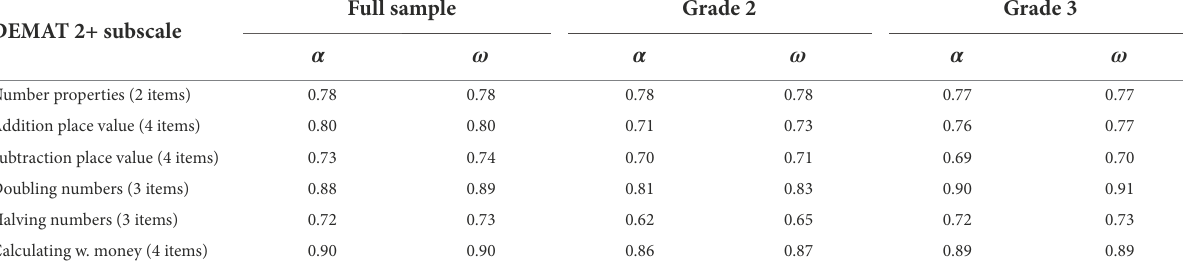
TABLE 5 Cronbach’s Alpha and Mc Donald’s Omega coefficients at first measurement time point.